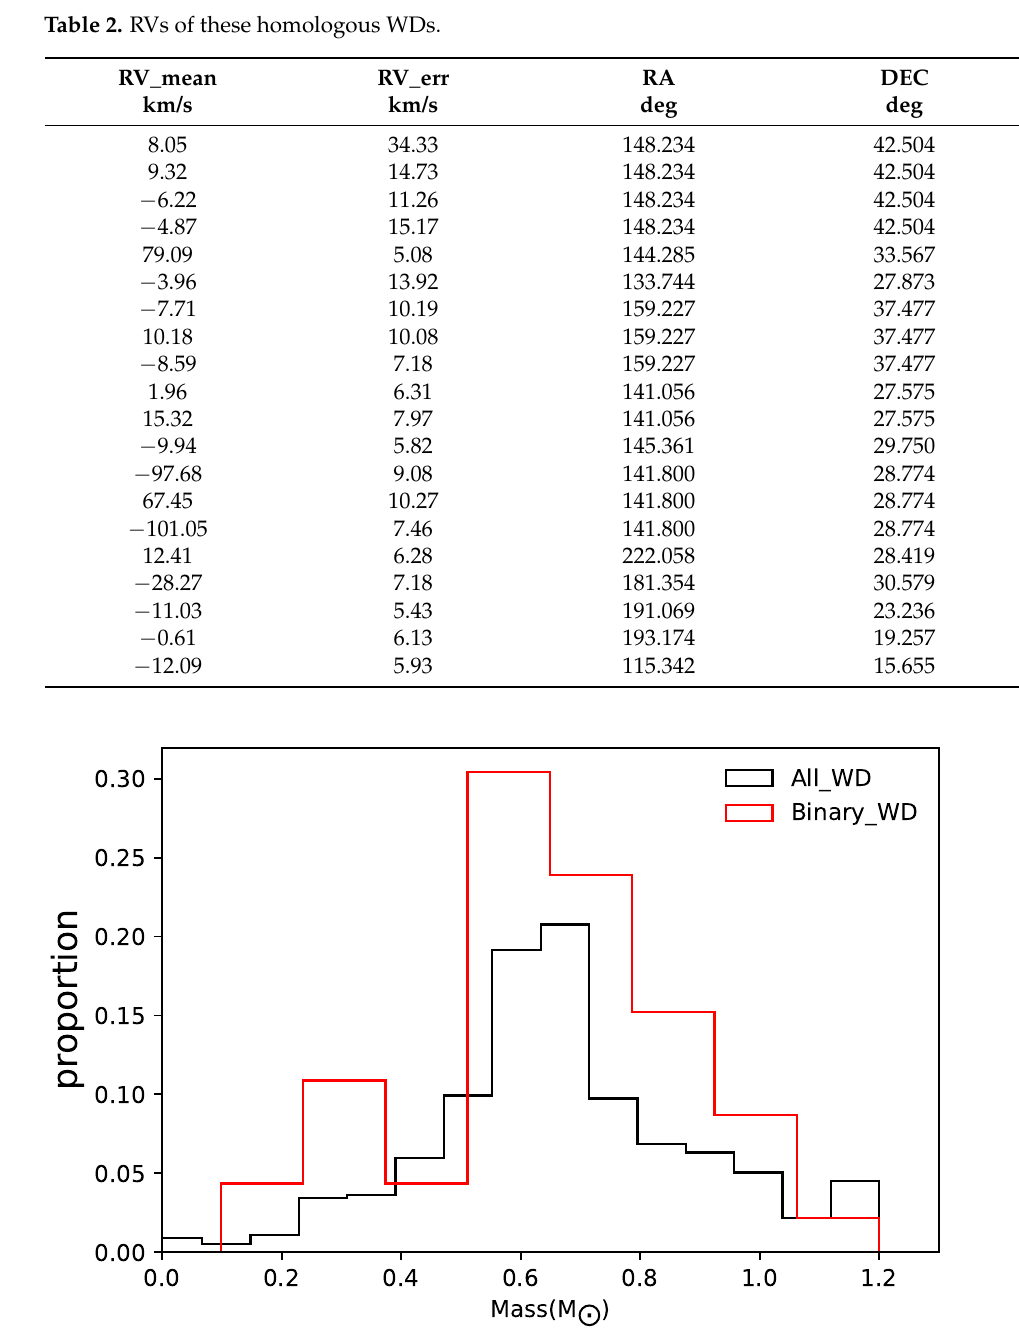
Figure 7. Comparison of the mass distribution of WD binary candidates and single WDs. Black: WD single stars. Red: WD binary